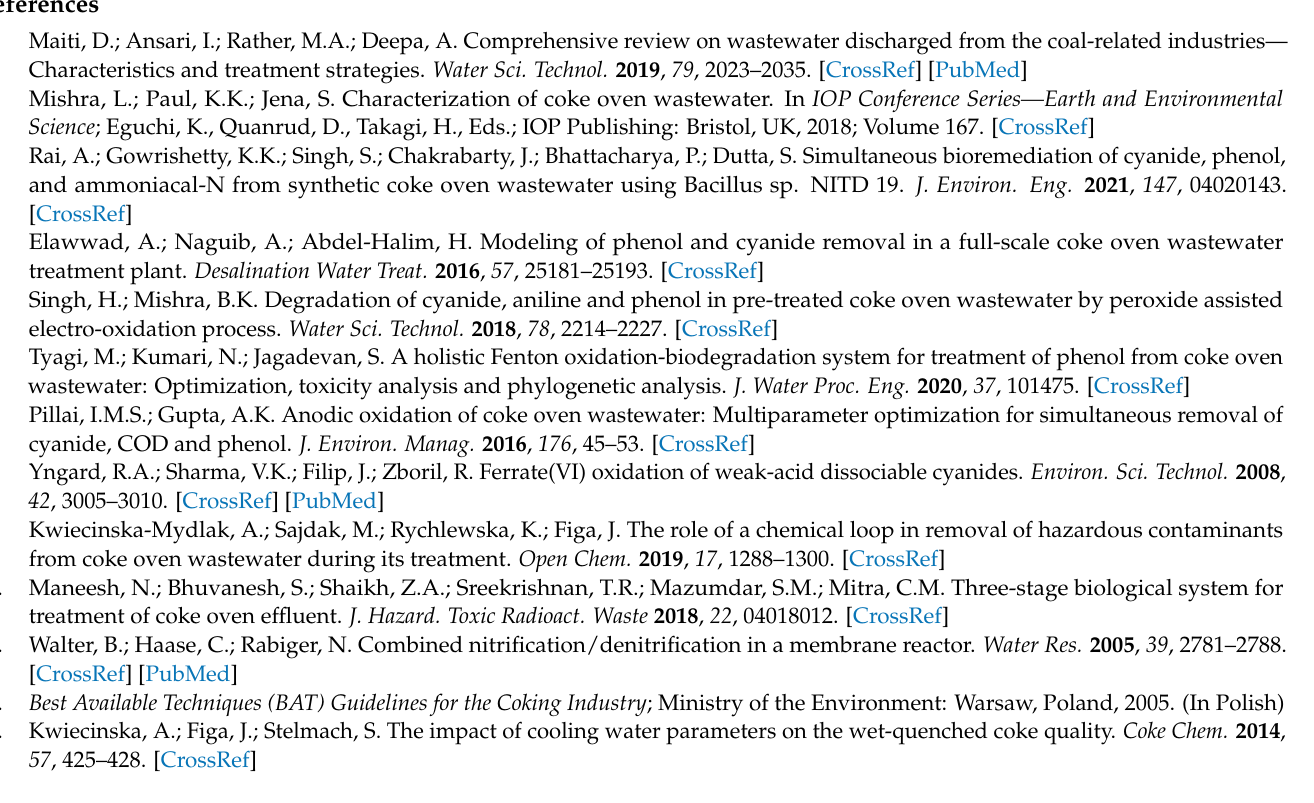
pressure driven membrane filtration: 1—feed water tank, 2—membrane module, 3—recirculation pump, 4—valve, 5—backflushing system, 6—compressor, 7—weight. Figure S2. The pilot installation of Millipore for high pressure membrane filtration; 1—membrane module, 2—membrane pump, 3—tank. Figure S3. The size of solids in coke oven wastewater analyzed with Sald 2300 (Shimadzu, Kyoto,